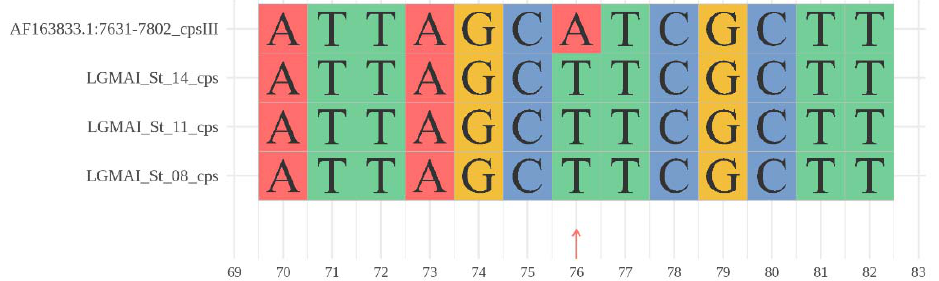
Figure 2. Whole-genome sequence data-based serotyping for Streptococcus agalactiae. Blast alignment among the three cps loci obtained from the LGMAI’s Streptococcus agalactiae genomes and the serotype III query sequence. Thirteen-nucleotide window extract showing the only mutation observed at position